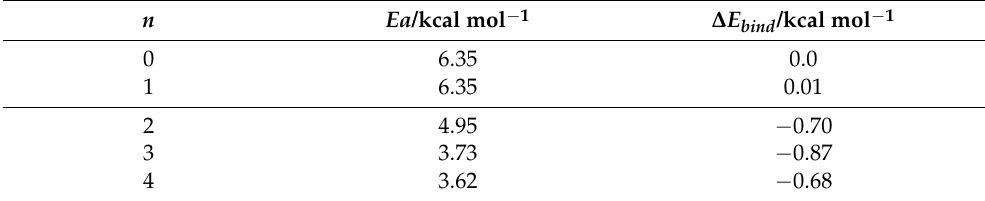
Table 3. The diffusion (activation) barriers of Li + (H 2 ) n ( n = 0–4) on the GNF(19) surface ( Ea in kcal/mol) calculated at the CAM-B3LYP/6-311G(d,p) level. The term ∆ E bind refers to the differences in binding energies in the transition state (TS) and binding state (per H 2 molecule in kcal/mol).